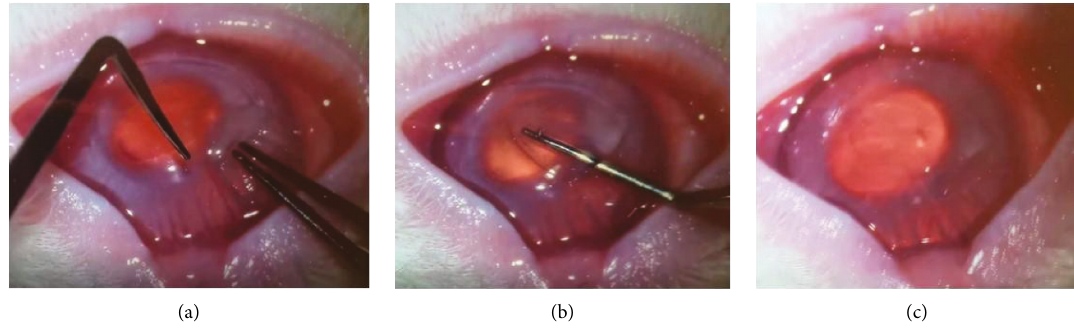
Figure 1: Schematic diagram of lens